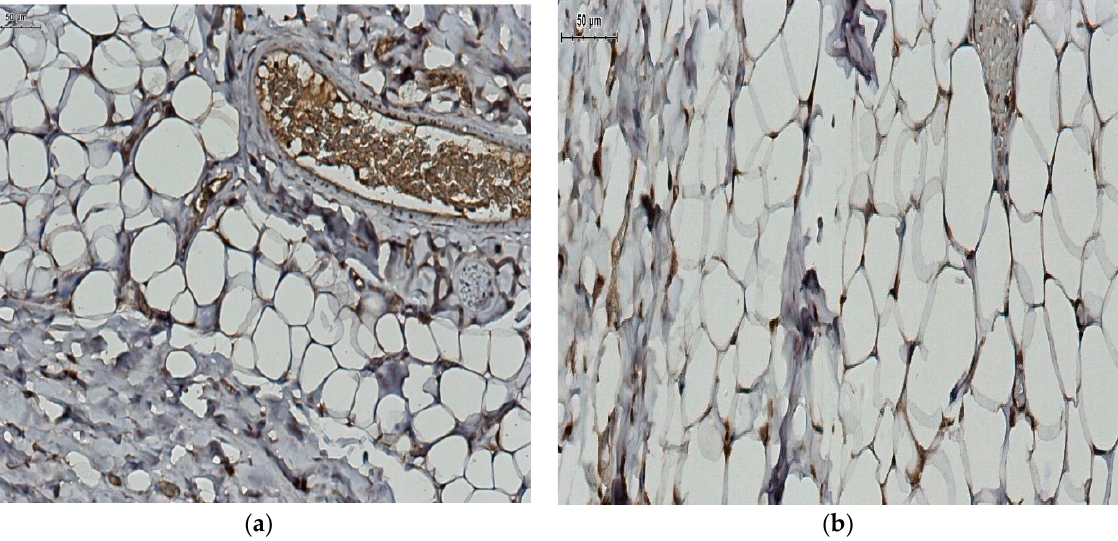
Figure 5. AdipoR2 immunoexpression ( a ) control group—AdipoR2 positive immunoexpression, ( b ) obese patient—AdipoR2 very low immunoexpression.